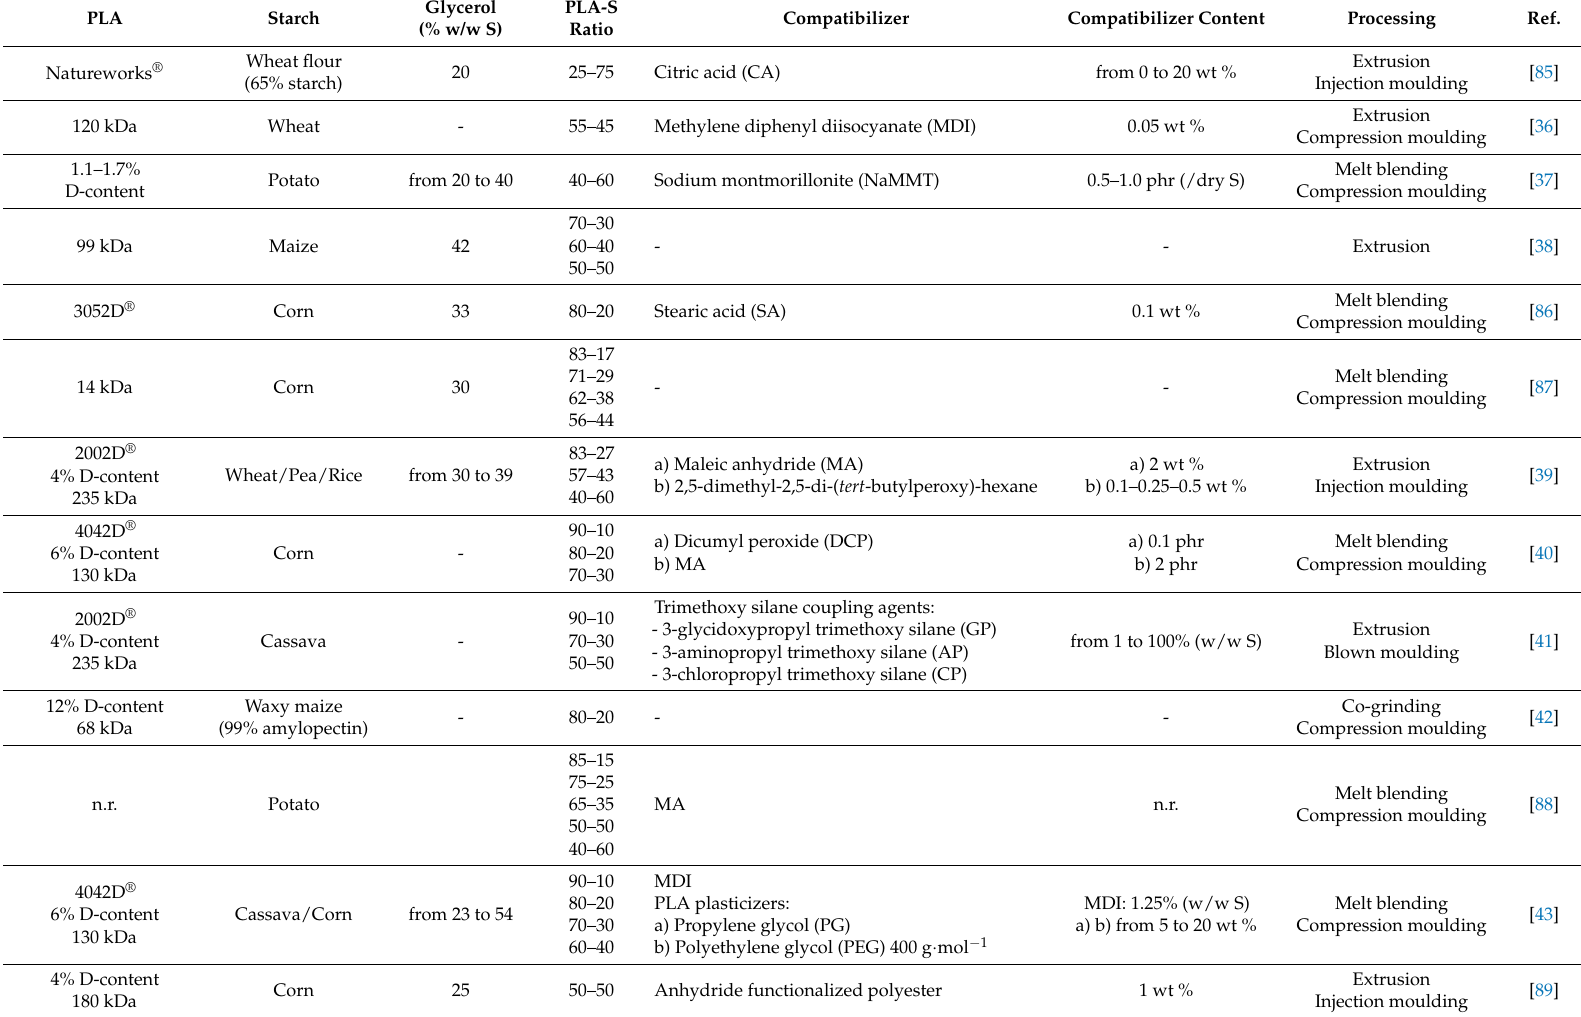
Table 4. Examples of PLA-starch blends with or without incorporation of a